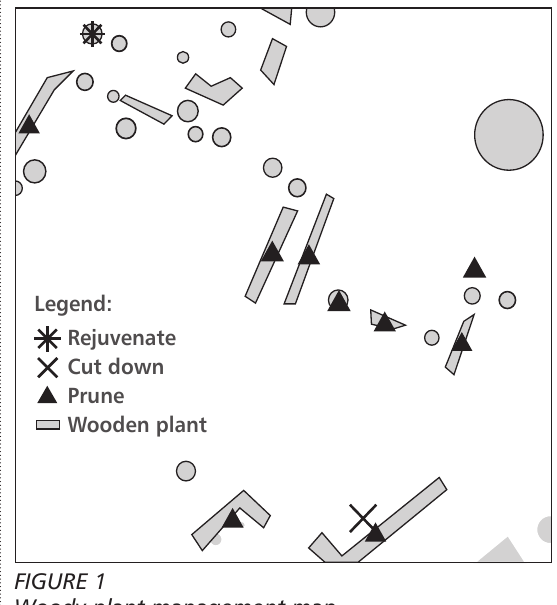
Phases of photogrammetric development, as a result of technological innovations (source